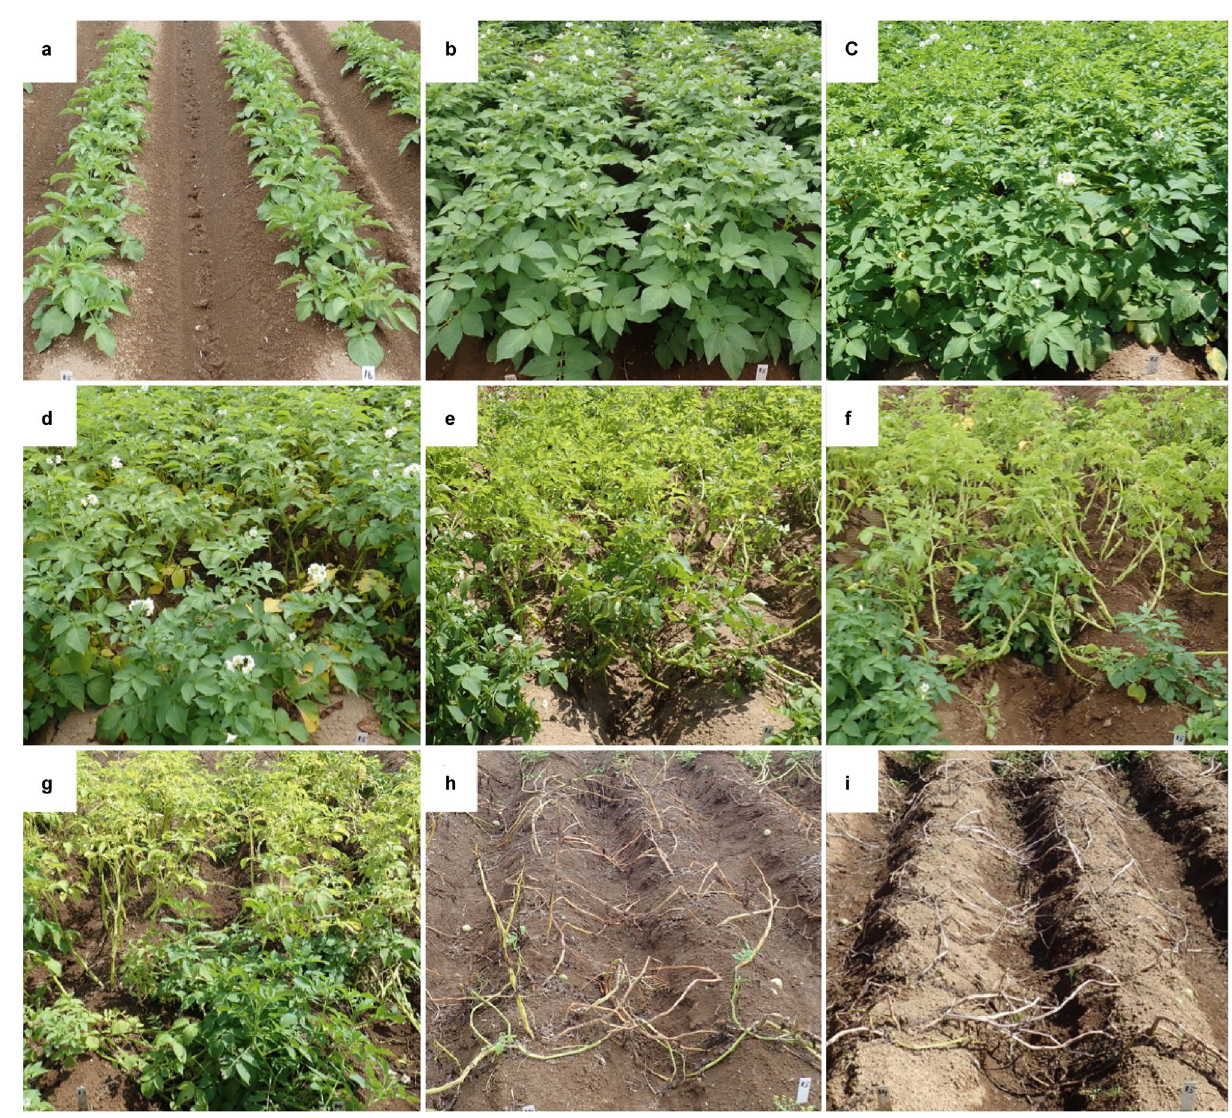
Figure 3. Symptom development at the same place in a non-controlled potato field in 2018. ( a ) Before the first observation of late blight in a field on 15 June. ( b ) First observation of late blight in the field on 6 July. ( c ) First observation of late blight on the sampled plants on 20 July. ( d ) The number of lesions increased on 27 July. ( e ) The number of lesions decreased due to a heat wave on 3 August. ( f ) Most infested leaves were dried and senesced by 25 August. ( g ) An epidemic occurred on 18 August. ( h) All plants died of late blight by 31 August. ( i ) The plants were dried by 25